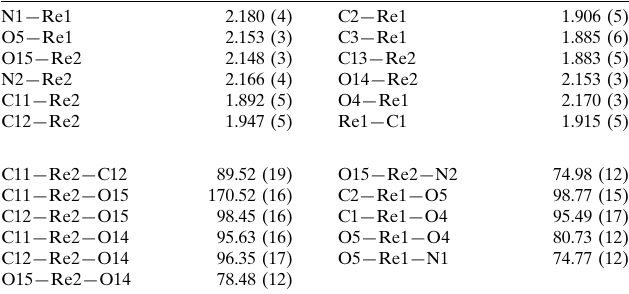
Selected geometric parameters (A˚ , (cid:2) ).